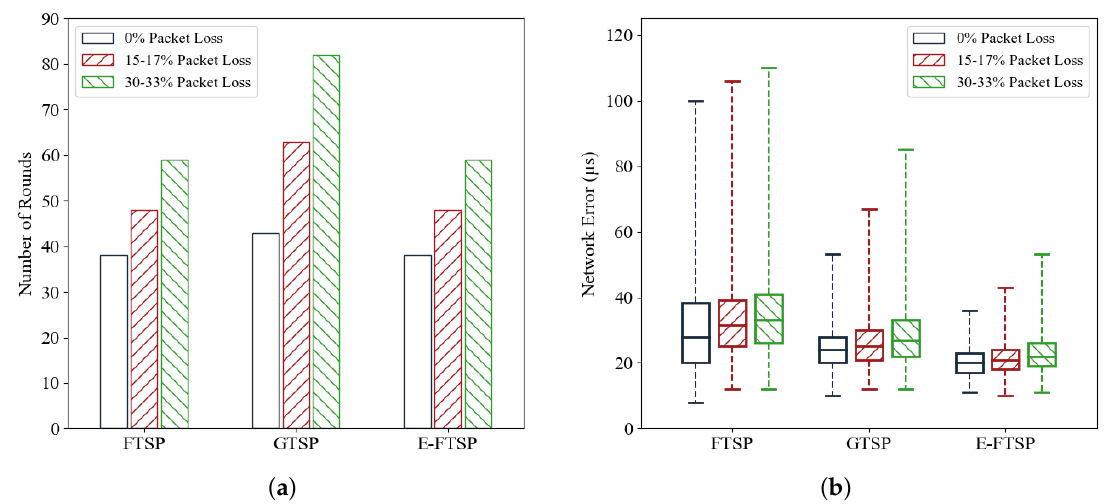
Figure 14. ( a ) Number or rounds required to synchronize entire network for different packet loss ratios. ( b ) Network synchronization error of each protocol with different packet loss